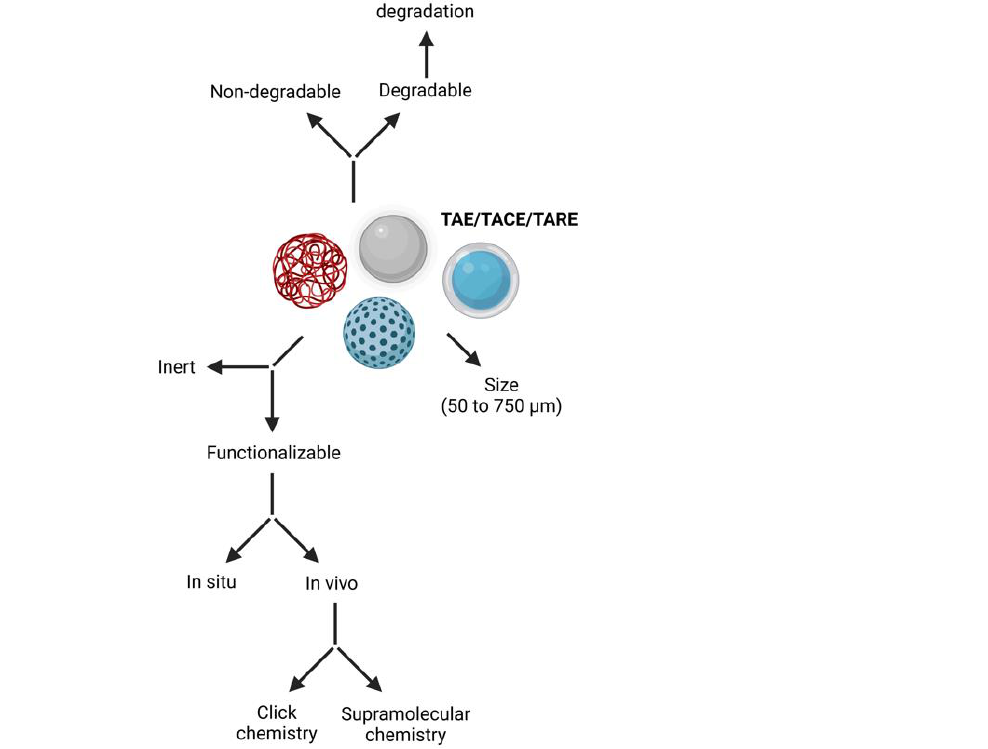
Figure 3. Overview of microsphere properties and functionalizations. Details regarding the clinical features and pre-clinical set-ups are described in Sections 2–4. Created with BioRender.com.